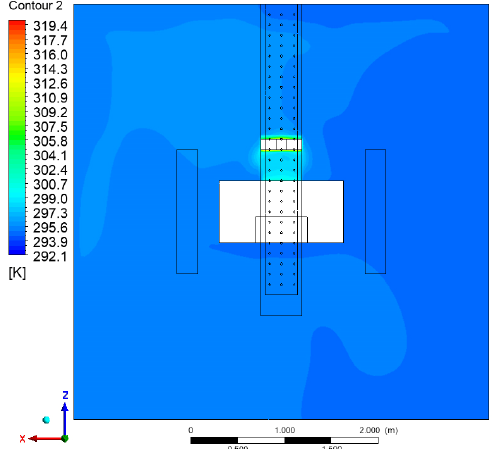
Figure 23. The temperature distribution of the Y = 0.6 m section.